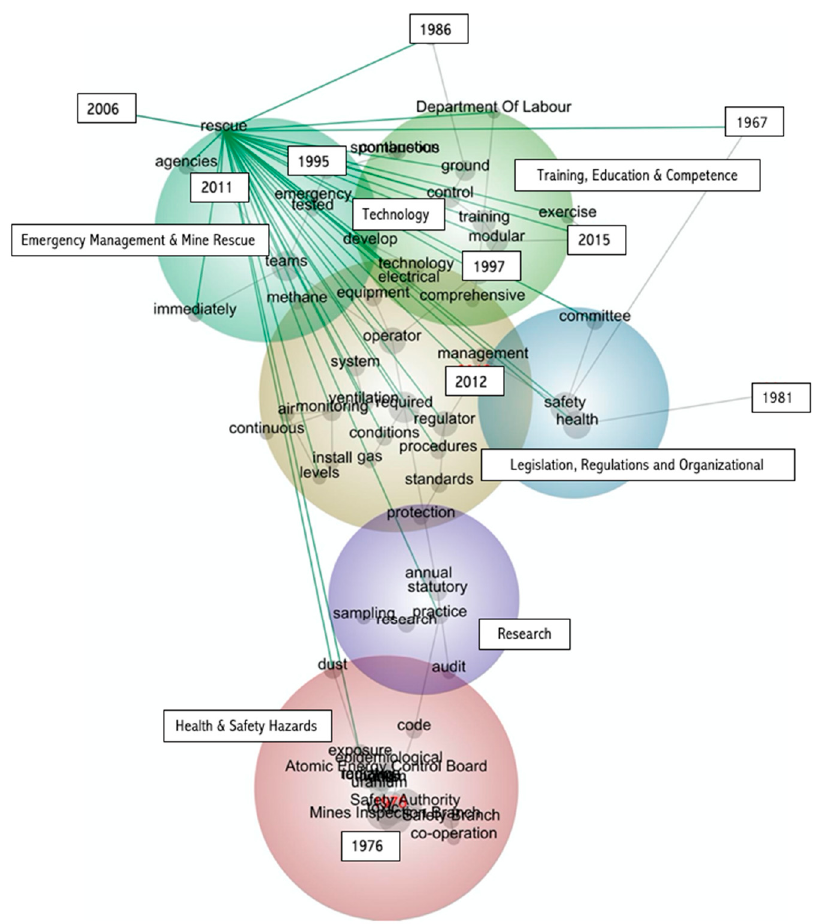
Figure 1. Concept map generated by Leximancer, resulting in six major themes: Legislation, Regulations and Organizational Structure (yellow and blue), Health and Safety Hazards (red), Emergency Management and Mine Rescue (green), Training, Education and Competence (light green), Technology (green/yellow overlap), and Research (purple).